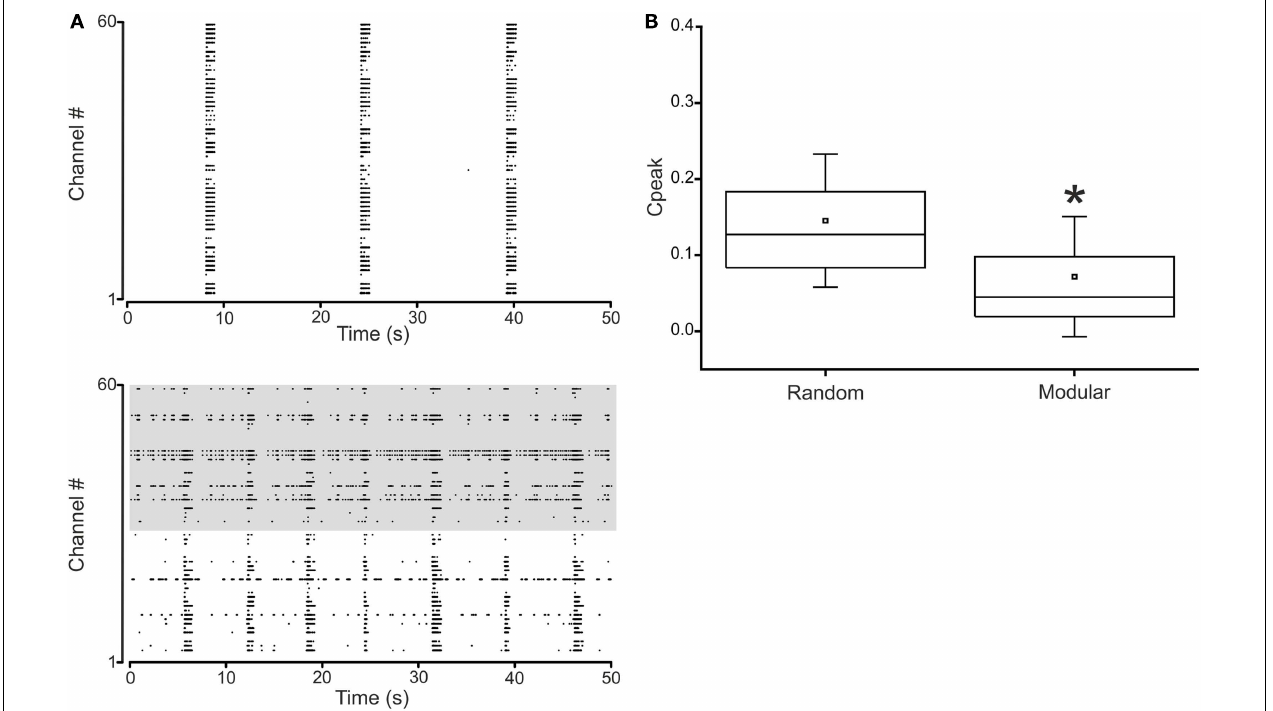
25DIV).The activity of 59 electrodes is depicted: each small vertical bar represents a spike, each line an electrode. (B) Box-plot of the cross-correlation peaks in N = 6 random and N = 6 modular cultures. Box range: percentile 25–75; box whiskers: percentile 5–95; line: median; square: mean. Mann–Whitney test for not-normal data, significance level = * p <